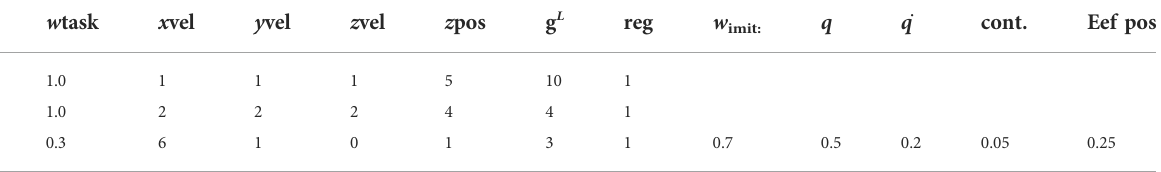
TABLE 2 Reward weights for quadruped